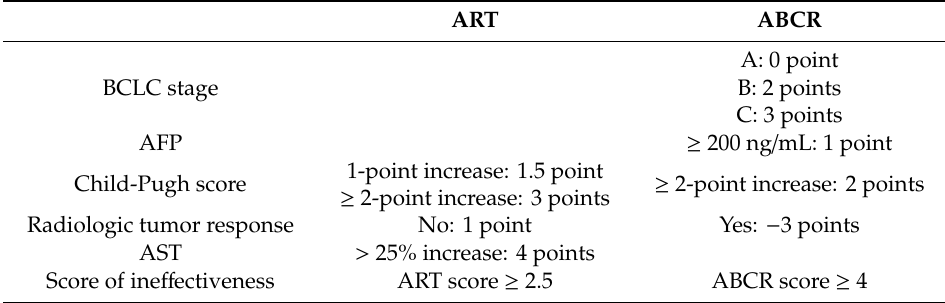
Table 1. Parameters used in ART and ABCR